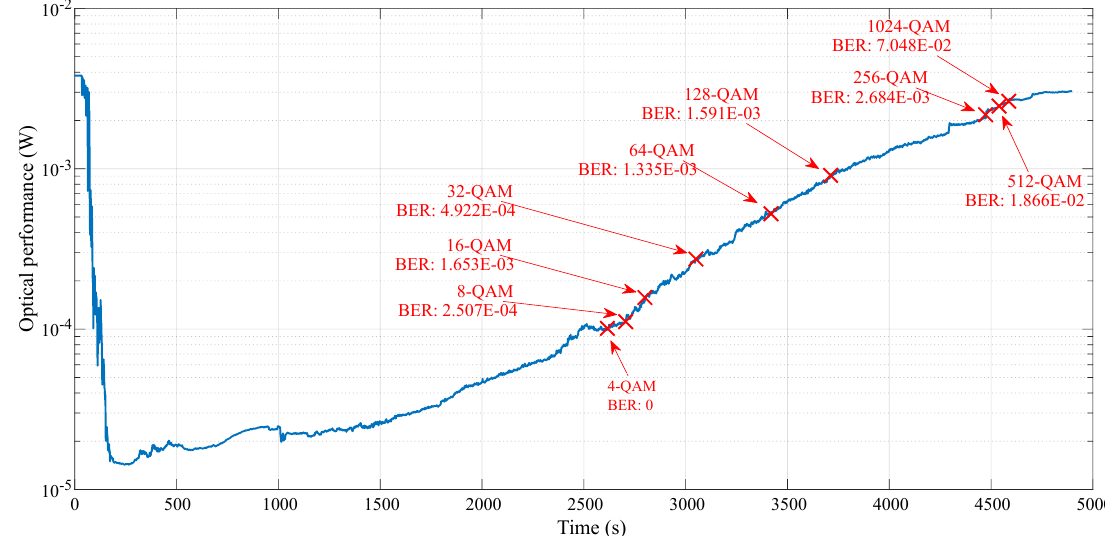
Figure 35. Fog dissipation with laser power levels and modulations with appropriate BER values.